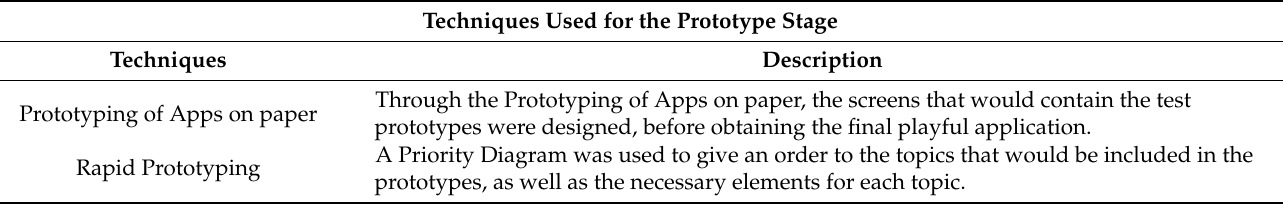
Table 6. Description of techniques used in the Prototype stage.